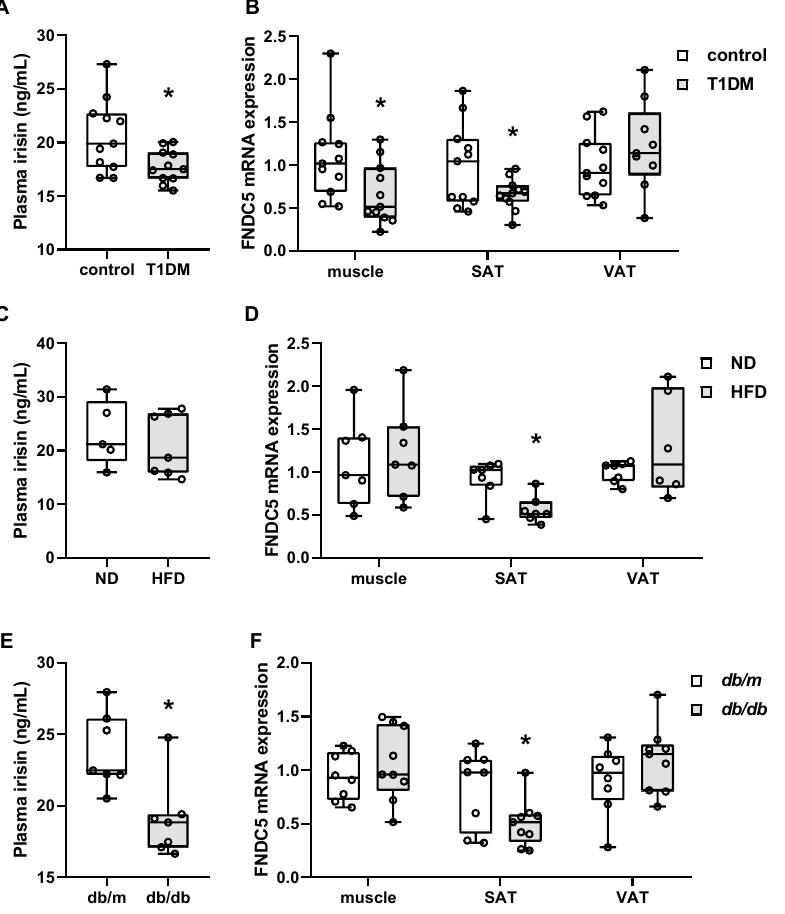
Figure 1. Circulating irisin and tissue FNDC5 gene expression in type 1 and type 2 diabetic mice. ( A , C , E ) Plasma irisin was measured in streptozotocin-induced type 1 diabetic (T1DM) mice ( n = 11/group), high-fat diet (HFD)-induced obese mice ( n = 7/group), and genetically obese db/db mice ( n = 8 for db/m , n = 9 for db/db ). ( B , D , F ) Muscle, subcutaneous adipose tissue (SAT) and visceral adipose tissue (VAT) FNDC5 gene expression was measured by real-time PCR. * p < 0.05 compared to the control, normal diet (ND), and db/m , respectively.